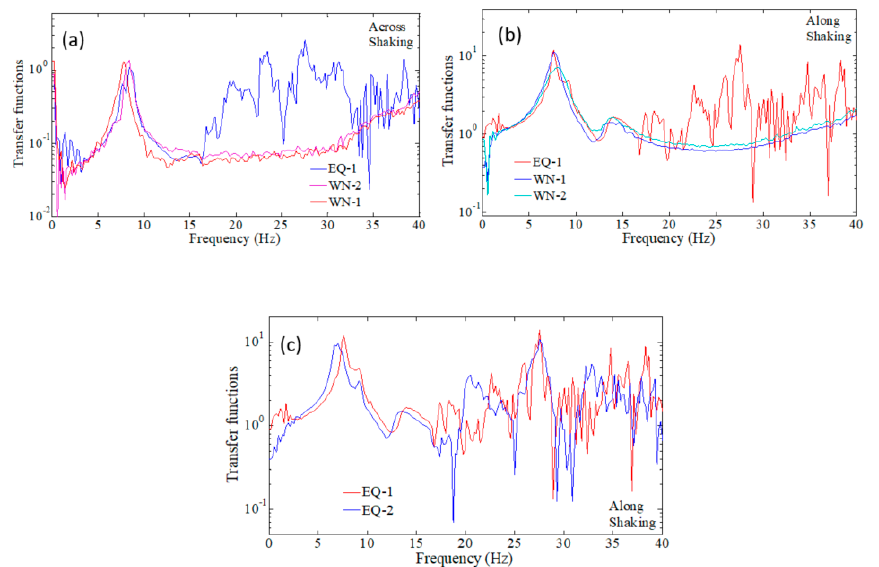
Figure 30. Transfer function estimates for the ( a ) across shaking direction during the loading states EQ-1, WN-1, WN-2; ( b ) along shaking direction during EQ-1, WN-1, WN-2; ( c ) along shaking direction during EQ-1,